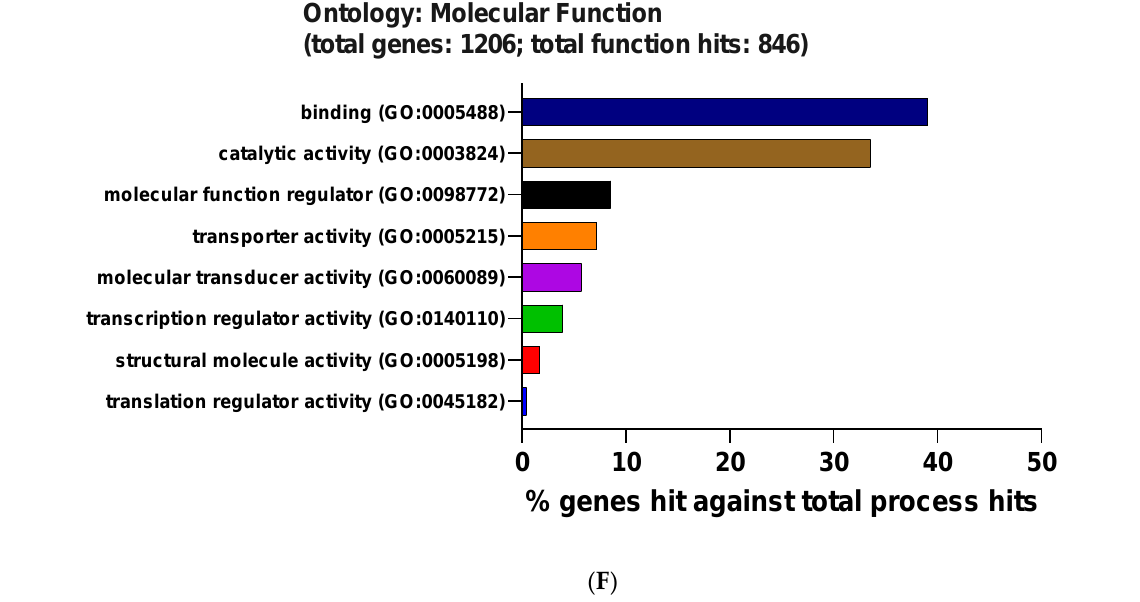
Figure 5. Functional enrichment analysis of DEGs from PANTHER. The DEGs were subjected to Gene Ontology (GO) classification with the PANTHER GO classification. ( A , B ) Biological process (BP) of down-regulated ( A ) and up-regulated ( B ). ( C , D ) Cellular component (CC) of down-regulated ( C ) and up-regulated ( D ). ( C ) Molecular function (MF) of down- regulated ( E ) and up-regulated ( F ).